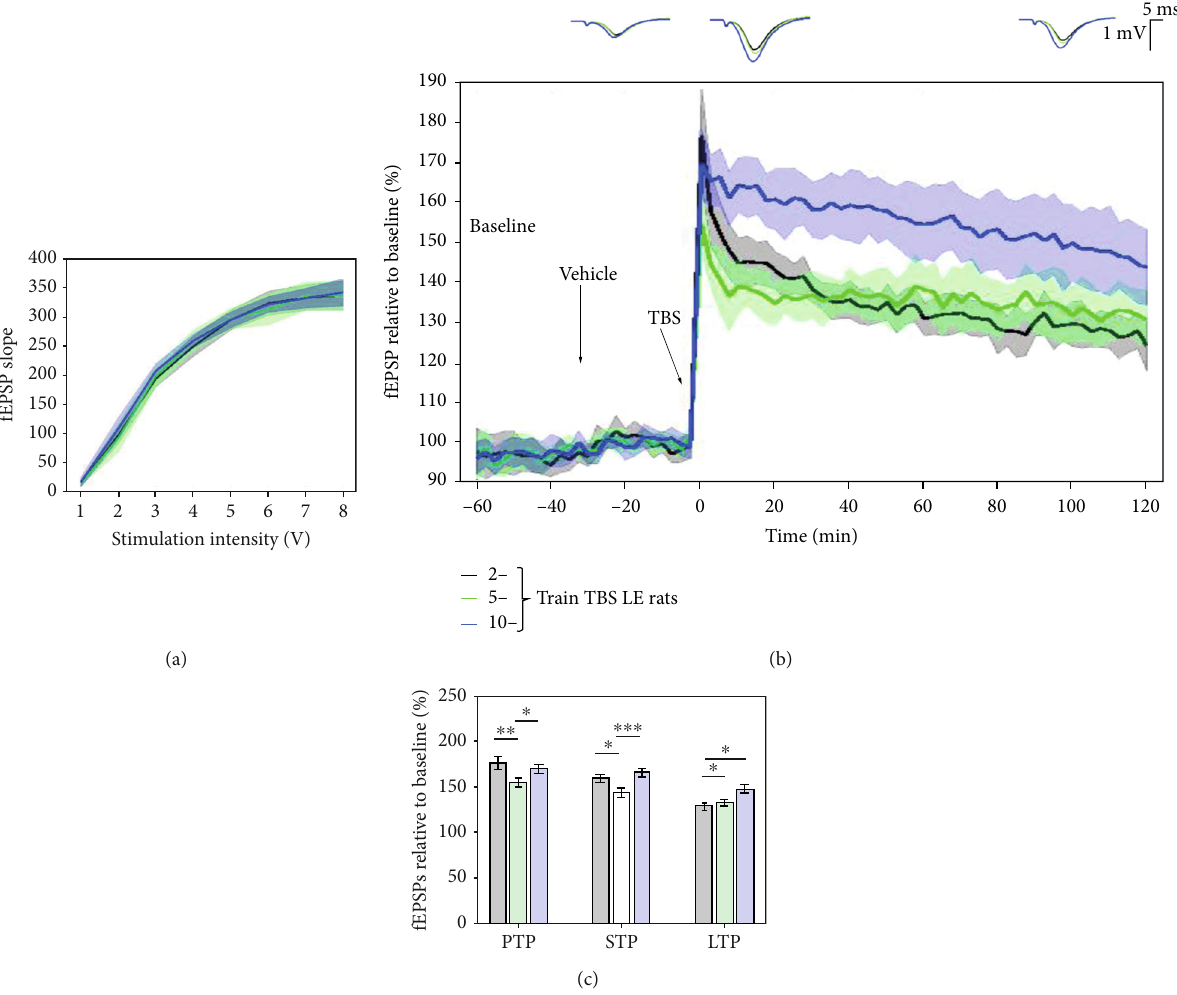
Figure 5: LTP response to di ff erent trains of the TBS protocol in LE rats. (a) Collective input/output curves between stimulation intensities and fEPSP slope overlap, showing no signi fi cant di ff erence in basal synaptic excitability. (b) When compared to 2 trains of TBS (black, n = 11 ), there was a signi fi cant increase in the LTP response induced by 5 trains (green, n = 10 ) and 10 trains (blue, n = 9 ) of TBS. Values represent means ± 95 % confidence intervals . Outsets above LTP curves represent average waveform fi eld potentials during 30min baseline prior to tetanisation and 0-30 min and 90-120 min posttetanisation. Horizontal bar: 1mV; vertical bar: 5ms. (c) PTP, STP, and LTP responses are presented as means ± 95 % confidence intervals . ∗ p value < 0 : 05 ; ∗∗ p value < 0 : 01 ; and ∗∗∗ p value < 0 : 001